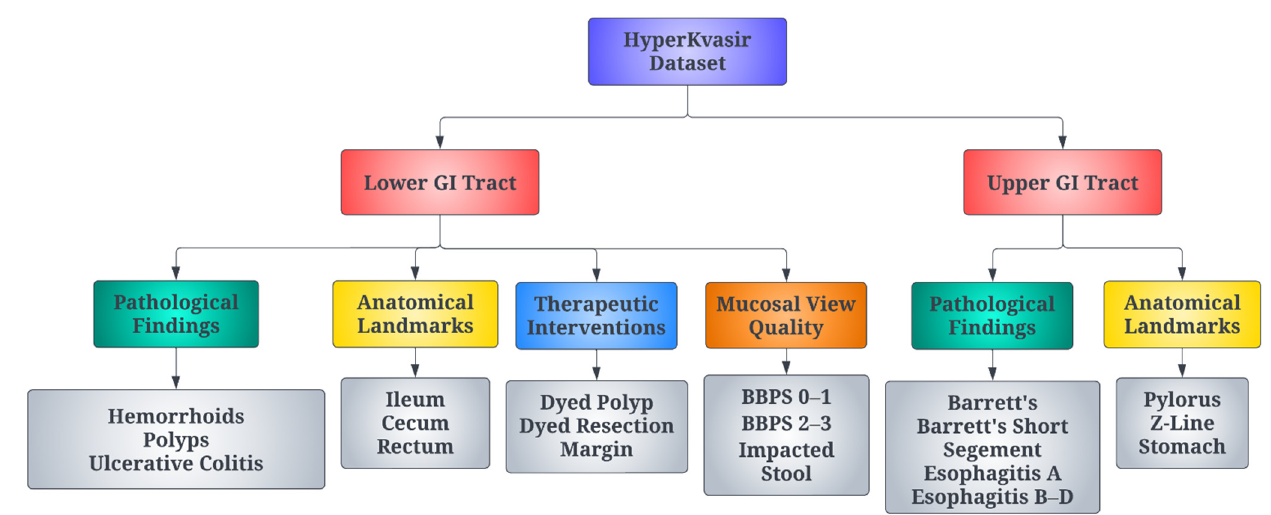
Figure 2. Structure of the dataset used for classification.